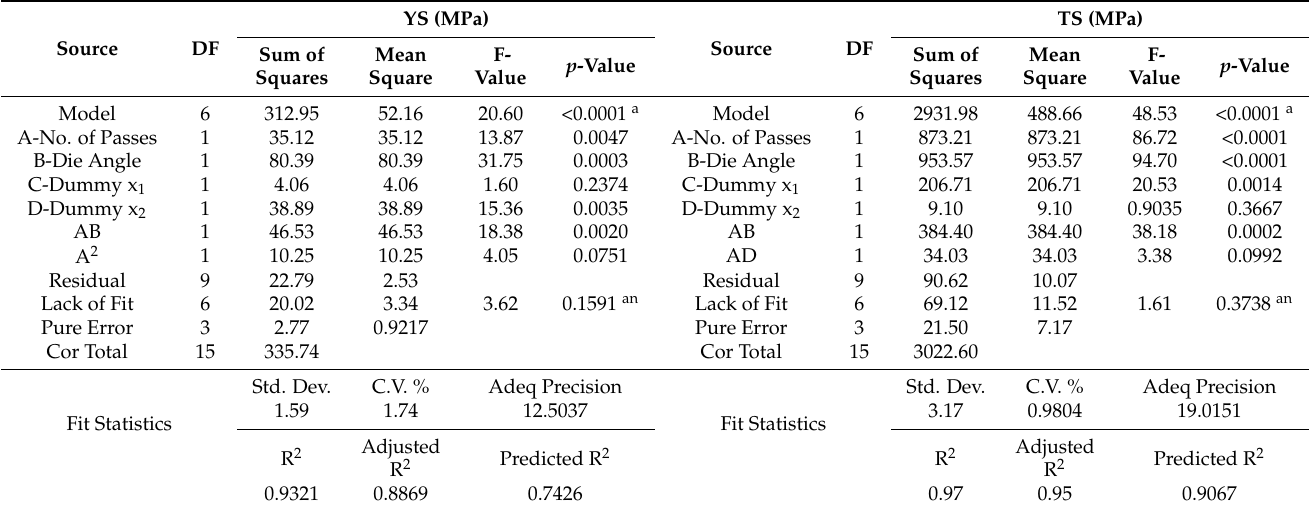
Table A4. Analysis of variance of YS and TS of